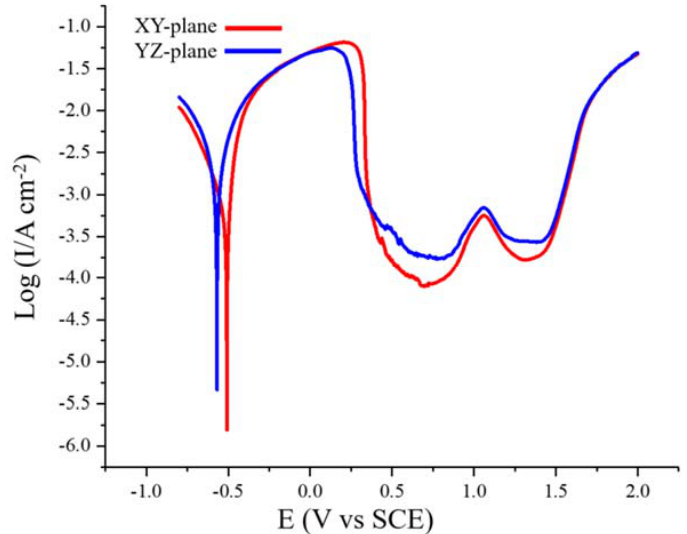
Figure 7. Potentiodynamic polarization curves of the SLM ‐ produced Fe 50 Mn 30 Co 10 Cr 10 HEA in 0.1 M H 2 SO 4 solution at 25 °C .